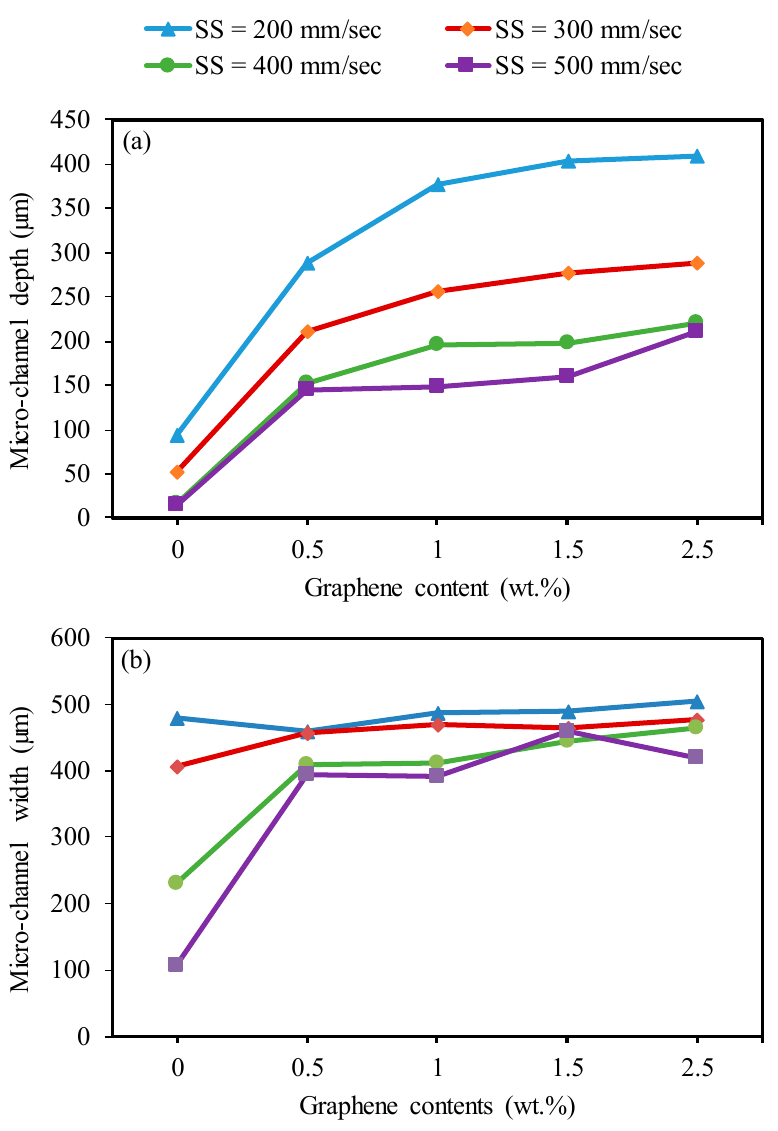
Figure 13. Effects of varying graphene reinforcement contents with laser speed on microchannel depth and width for machining base Al 2 O 3 , and GNP/Al 2 O 3 nanocomposites at F = 30 kHz. (a) Mi- crochannel depth, (b) Microchannel depth